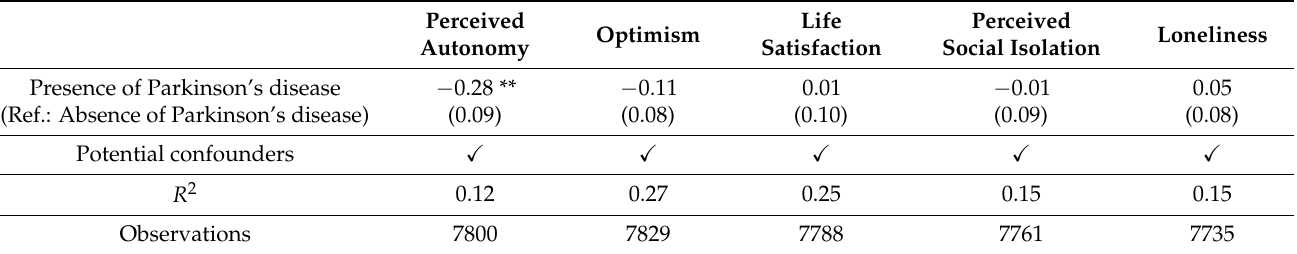
Table 3. Determinants of psychosocial factors. Results of multiple linear regressions (additionally adjusting for depressive